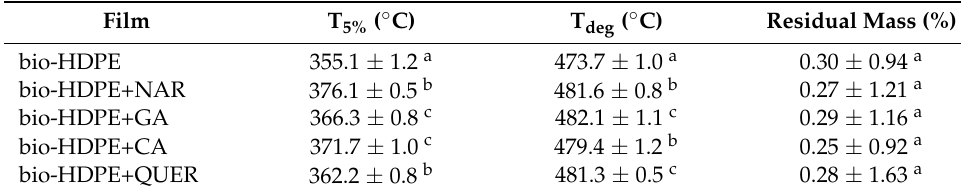
Table 4. Main thermal decomposition parameters of the thermo-compressed bio-based high-density polyethylene (bio-HDPE) films containing naringin (NAR), gallic acid (GA), caffeic acid (CA), and quercetin (QUER) in terms of onset degradation temperature measured for a mass loss of 5% (T 5% ), temperature of maximum degradation (T deg ), and residual mass at 700 ◦